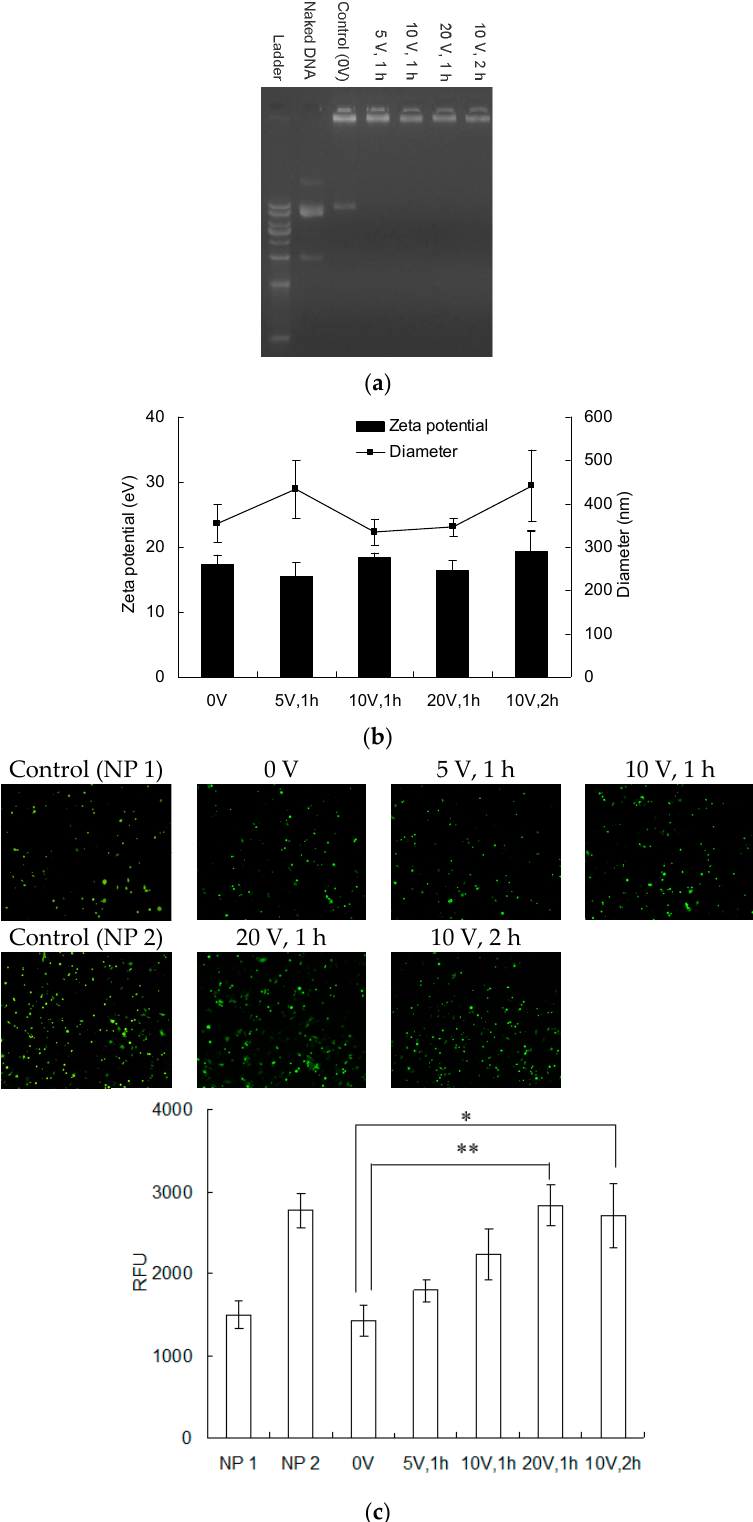
Figure 6. The release of DNA and PEI from PEMs for transfection application. After electrical field pretreatment, PEMs were kept in PBS for 48 h and the supernatant was collected. ( a ) The supernatant was loaded to agarose gel for electrophoresis to determine the complexation efficiency of PEI to DNA. ( b ) To determine the sizes and surface charges of DNA/PEI polyplexes in supernatant, DLS